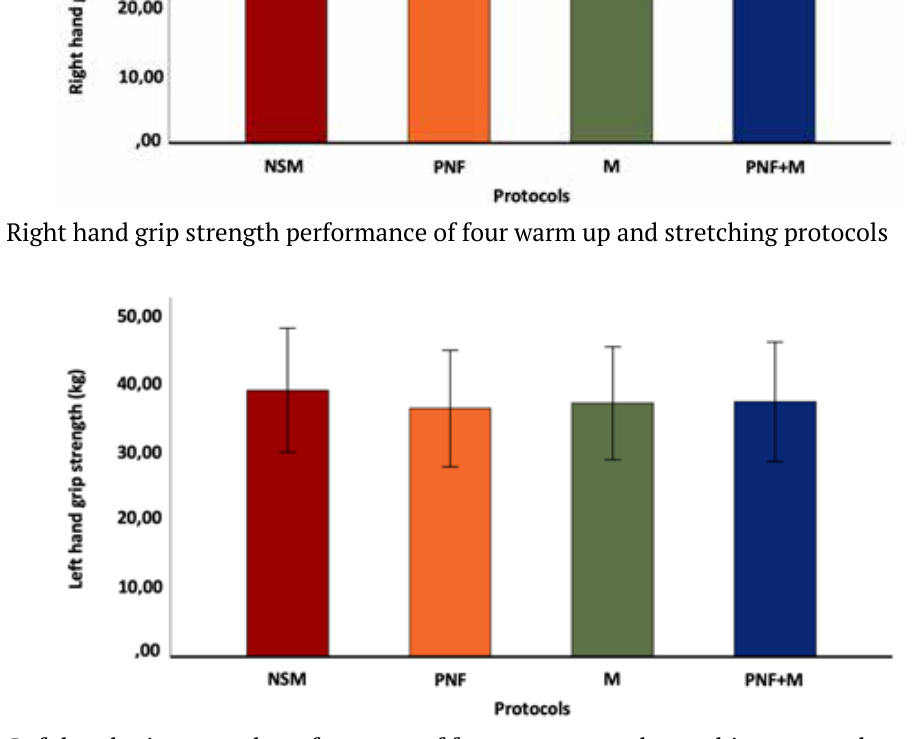
Figure 4. Left hand grip strength performance of four warm up and stretching